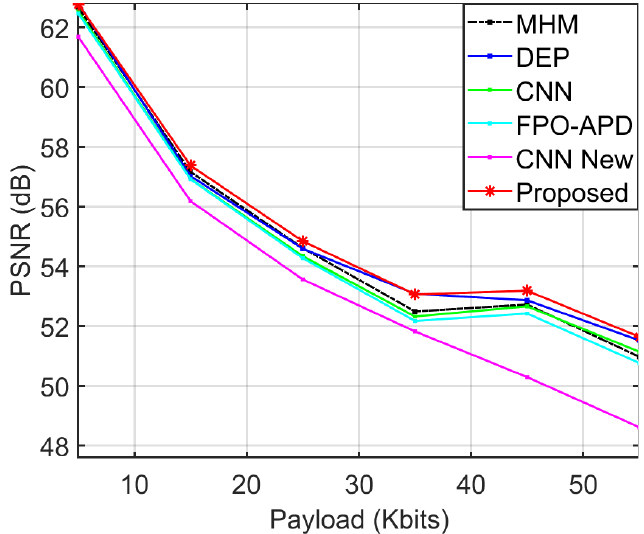
Figure 3. Comparison of PEH distribution obtained using rhombus, DEP, and CNN from the shadow layer of typical image Lena: ( a ) RIC = 1; ( b ) RIC = 3; ( c ) RIC = 5; ( d ) RIC = 7; ( e – h ) the nor- malized version for ( a – d ), respectively.